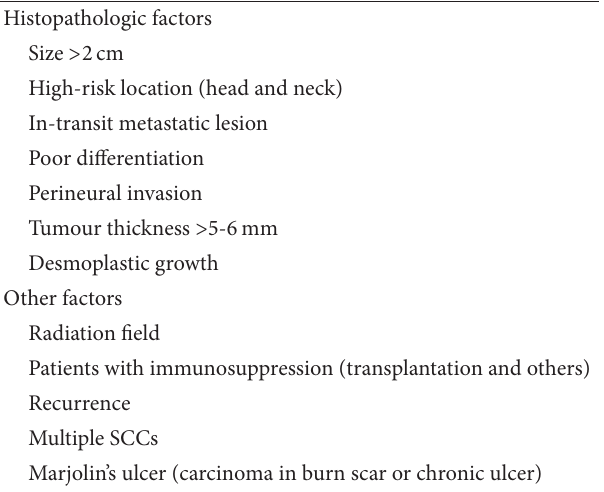
Table 2: Criteria for high-risk cutaneous squamous cell carcinoma [12, 22,